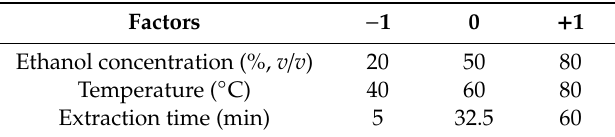
Table 2. Independent variables and selected levels used in the Box-Behnken design (BBD) for lemon pigment (LP) extraction from lemon peels.